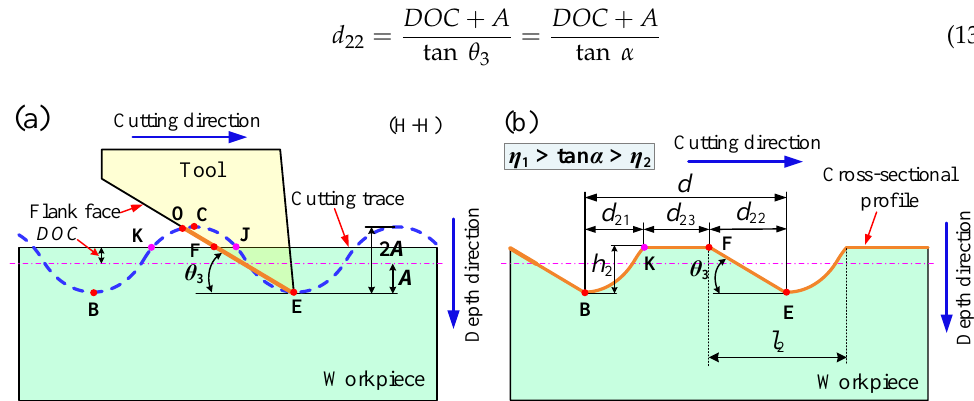
Figure 6. Flank face intersects with the KJ segment of the cutting trace on point O ( η 1 > tan α > η 2 ): ( a ) cutting trace; ( b ) cross-sectional profile of dimples.